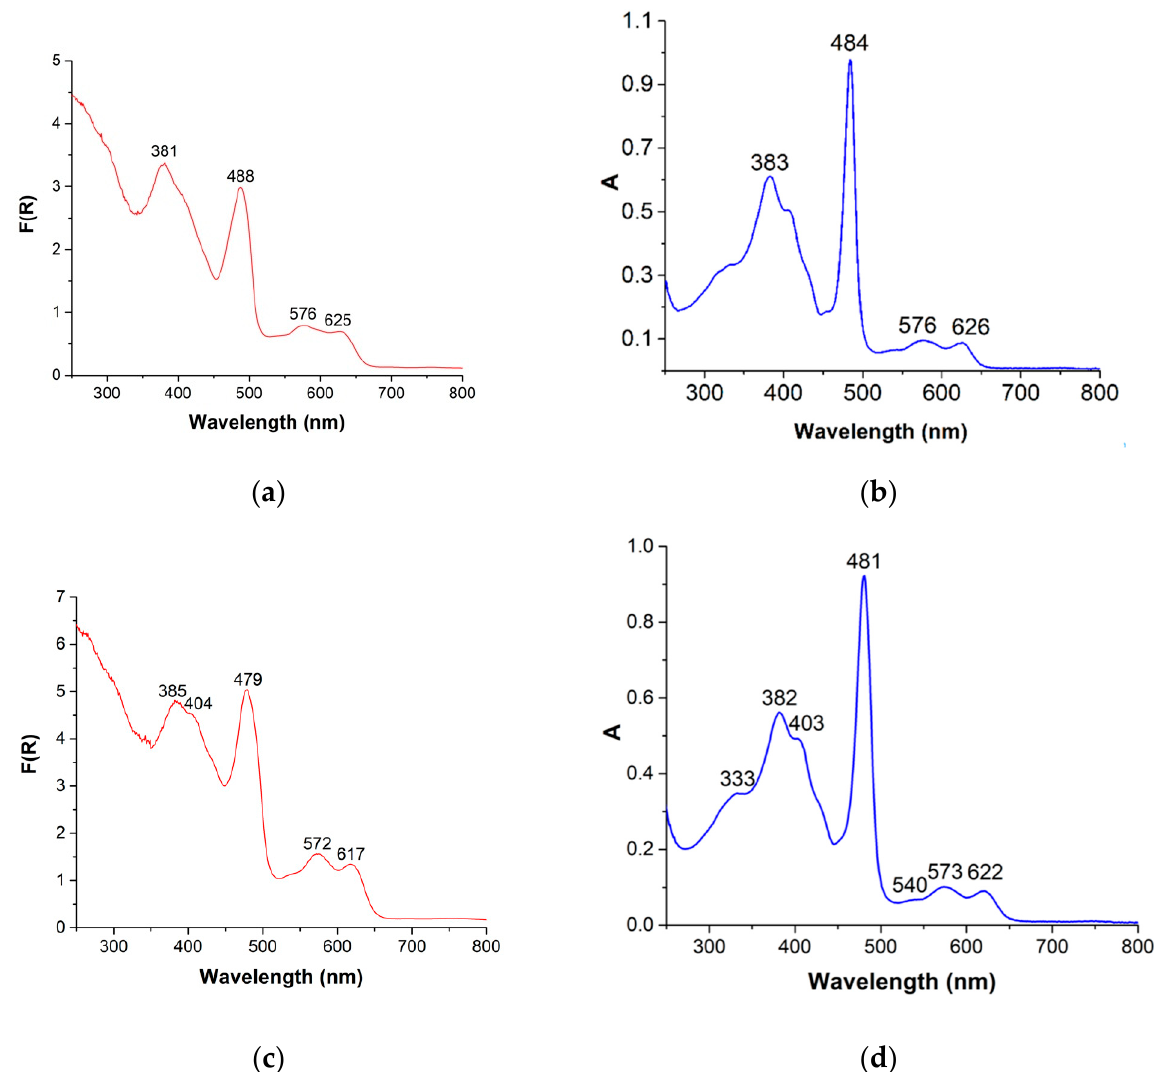
Figure 4. Kubelka-Munk transformed diffusion reflectance spectra of Mn(TMPIP)/TiO 2 -1 ( a ) and Mn(TMPIC)/TiO 2 -1 ( c ). UV-vis spectra of Mn(TMPIP) ( b ) and Mn(TMPIC) ( d ) in chloroform.